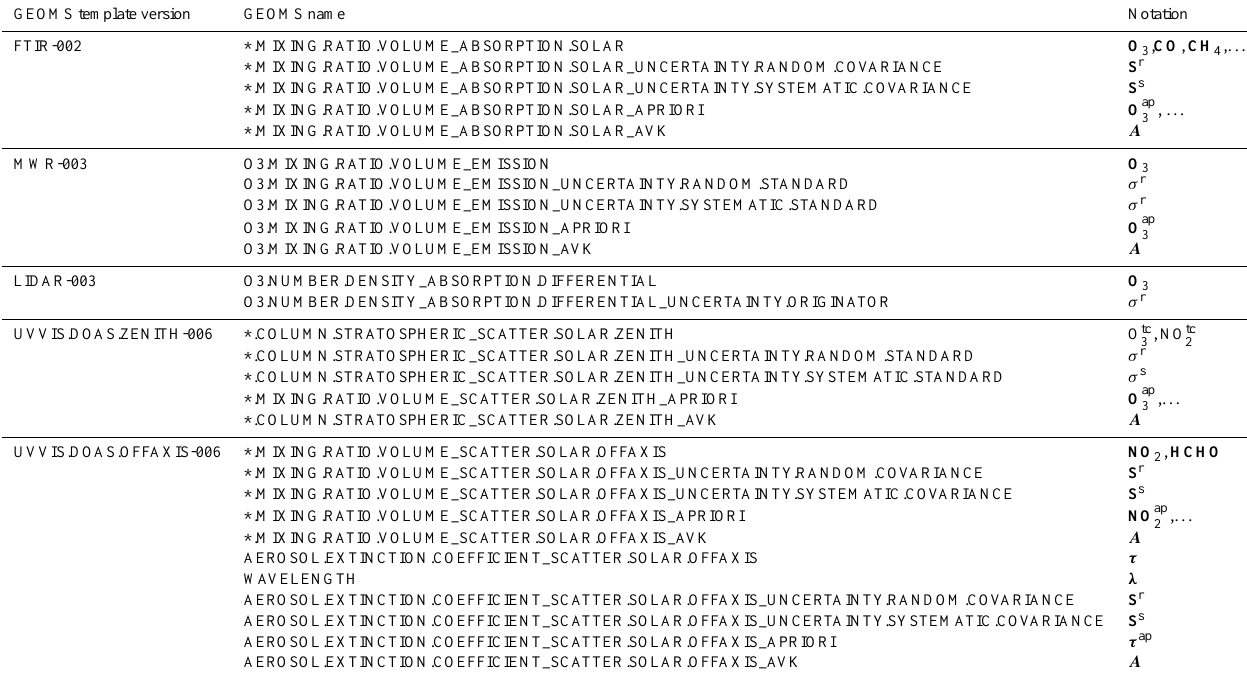
Table A1. List of GEOMS variable names, notations and corresponding GEOMS